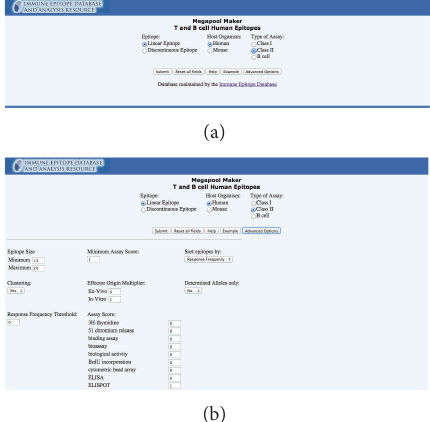
Figure 2: (a) Web application main page interface. (b) Web application “advanced options” page